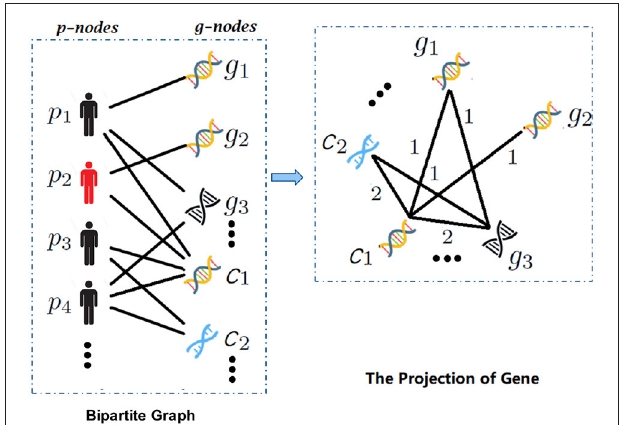
FIGURE 2 | The overview of bipartite graph and one-mode projection. With the input gene expression and copy number alteration (CNA) data, (1) bipartite graph expresses the structured relation between patients and multimodal data, e.g., the edges between patient p i and g j (in gene expression data) or c j (in CNA data); (2) the projection of gene, which establishes the connection of different modalities by one-mode projection.